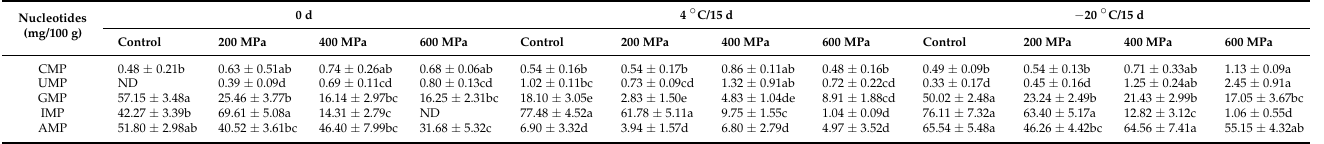
Table 3. The concentrations of 5 (cid:48) -nucleotides in red claw crayfish with different treatments. 0d 4 ◦ Nucleotides (mg/100g)